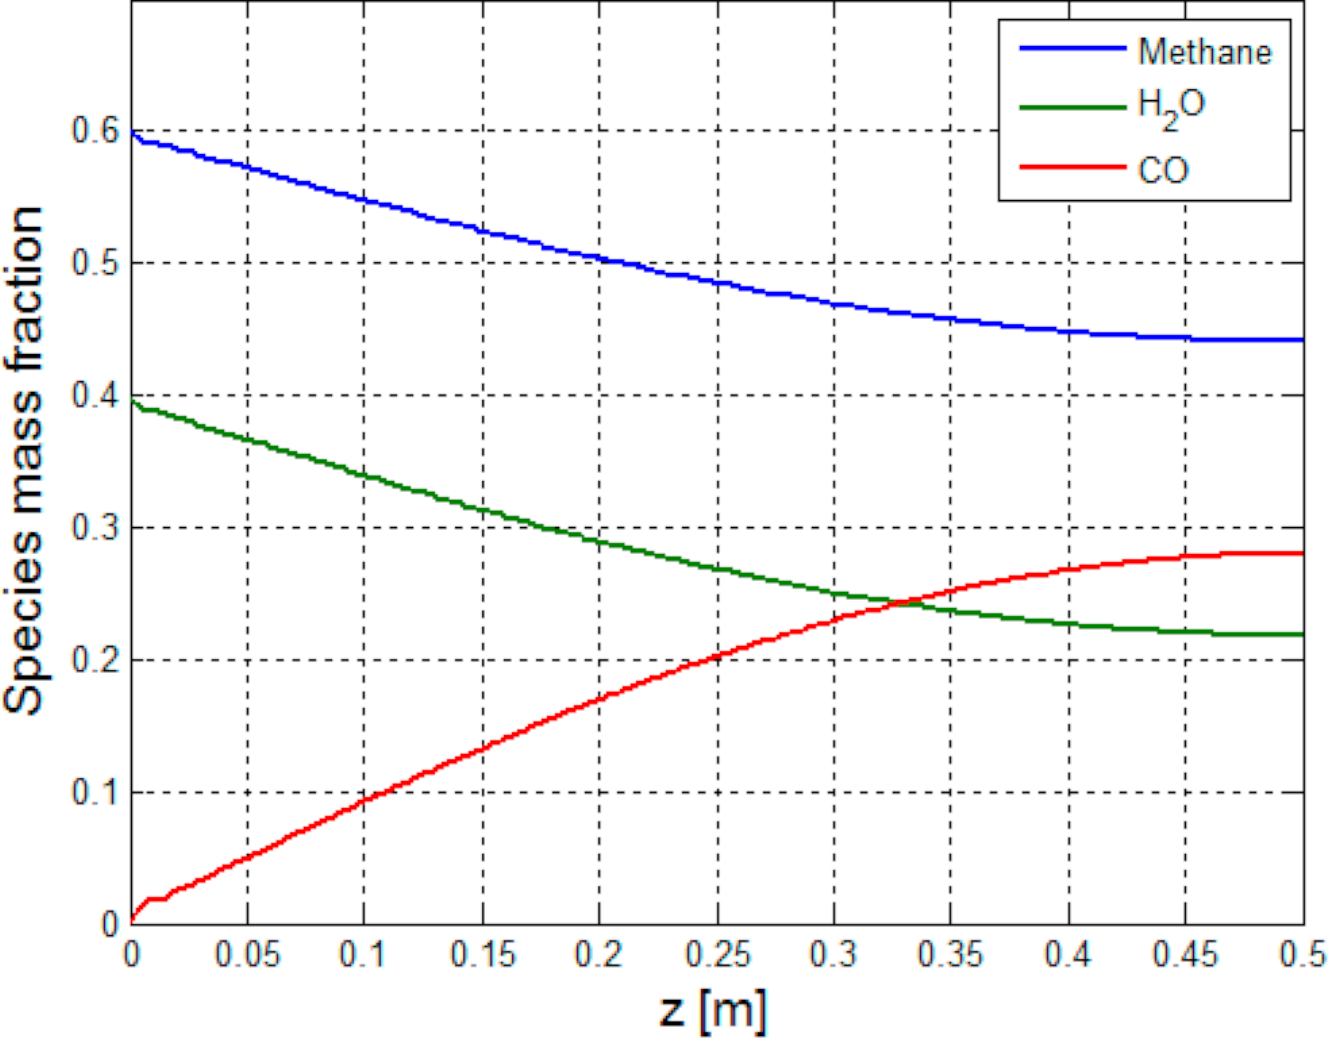
Figure 20. Methane, steam, and carbon monoxide mass fractions as function of the MSR